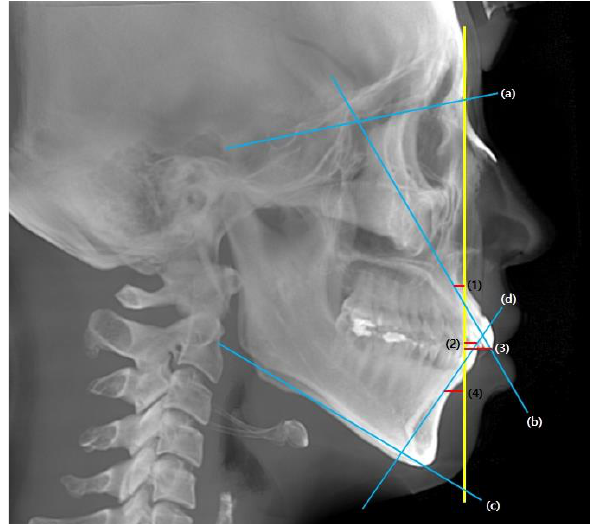
Figure 1. ( A ), CBCT 3D image view. The image was oriented along the Frankfort horizontal plane in reference to the right porion, right orbitale, and left orbitale. ( B ), CBCT-synthesized lateral ceph- alogram was constructed in accordance with orientation.